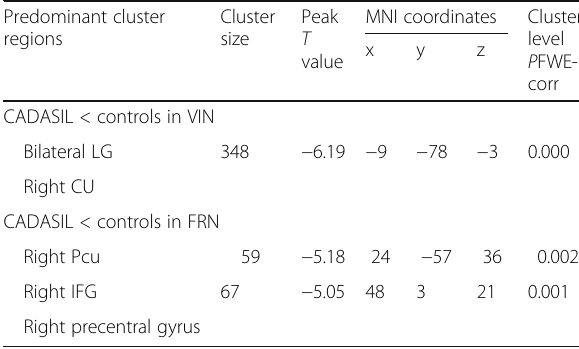
Table 4 Significant inter-group ICA differences between CADASIL patients and controls Predominant cluster